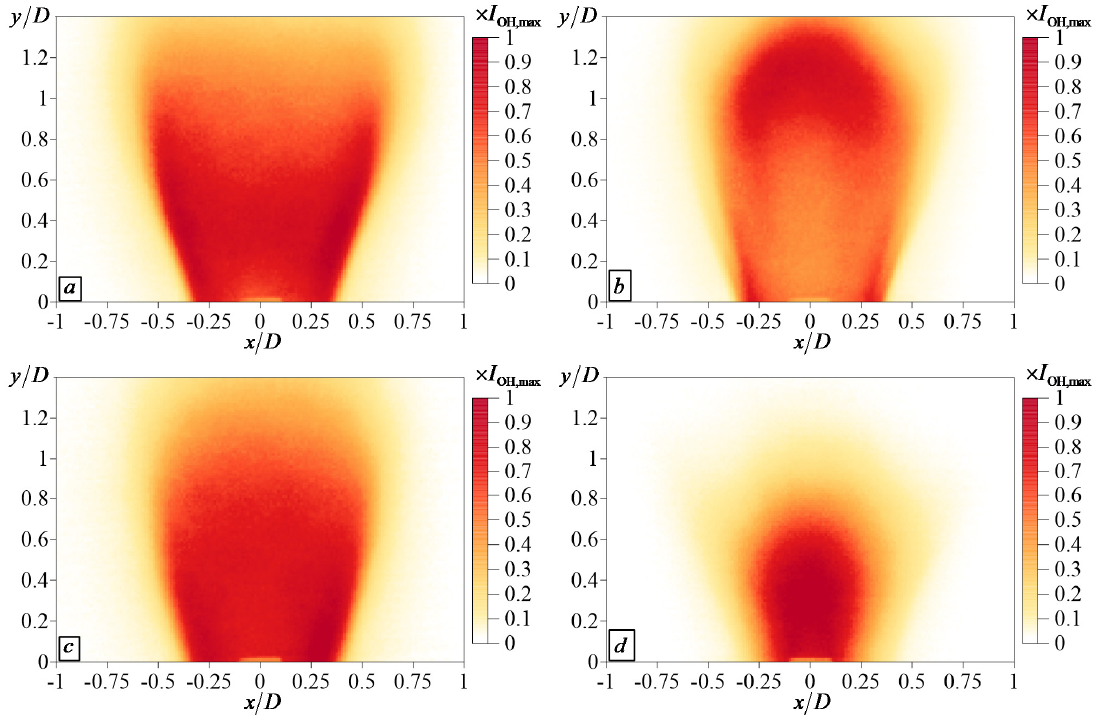
Figure 11. Time-averaged OH* chemiluminescence images for methane ( a , c ) and syngas ( b , d ) flames at normal conditions ( a , b ) and elevated pressure and temperature ( c , d